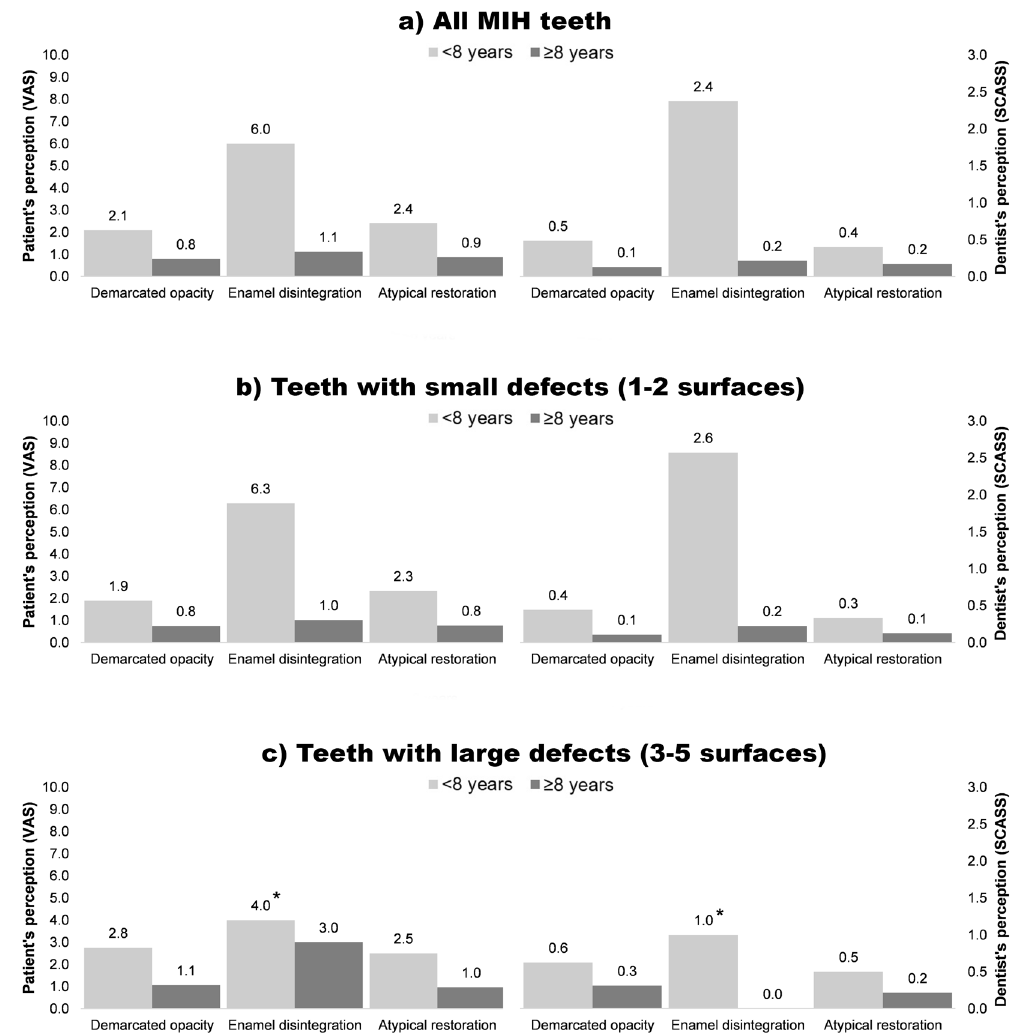
Figure 3. MIH-related hypersensitivity plotted according to the size of the MIH lesions in younger (< 8 years) and older (≥ 8 years) children. *Mean value is based on data from only one